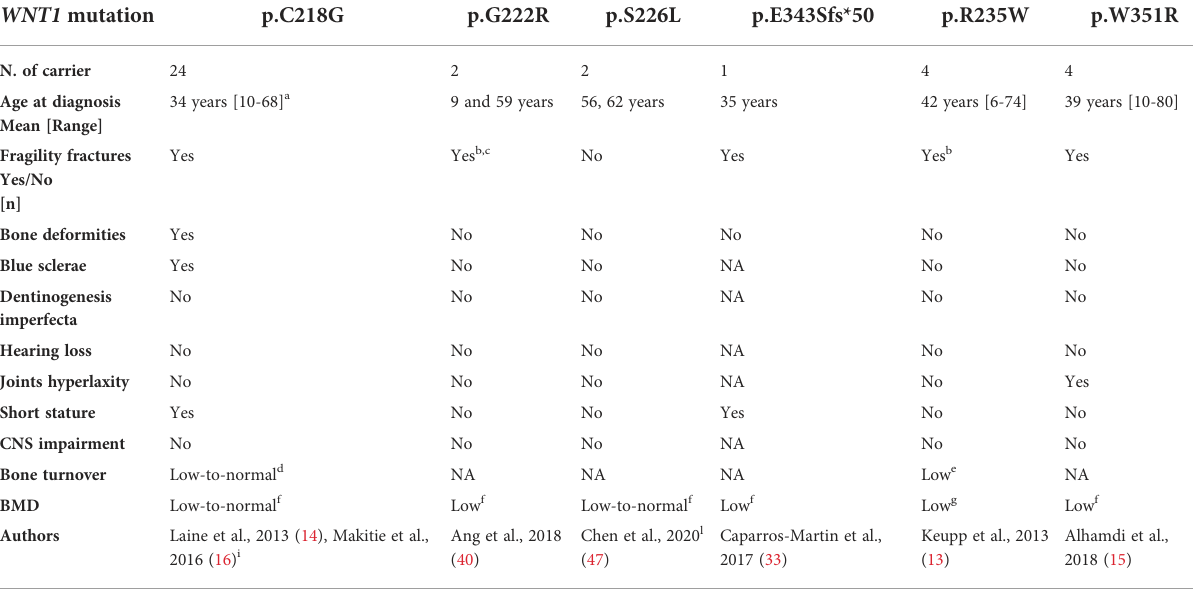
TABLE 3 Clinical and genetic data of germline heterozygous missense WNT1 variants reported in the literature. WNT1